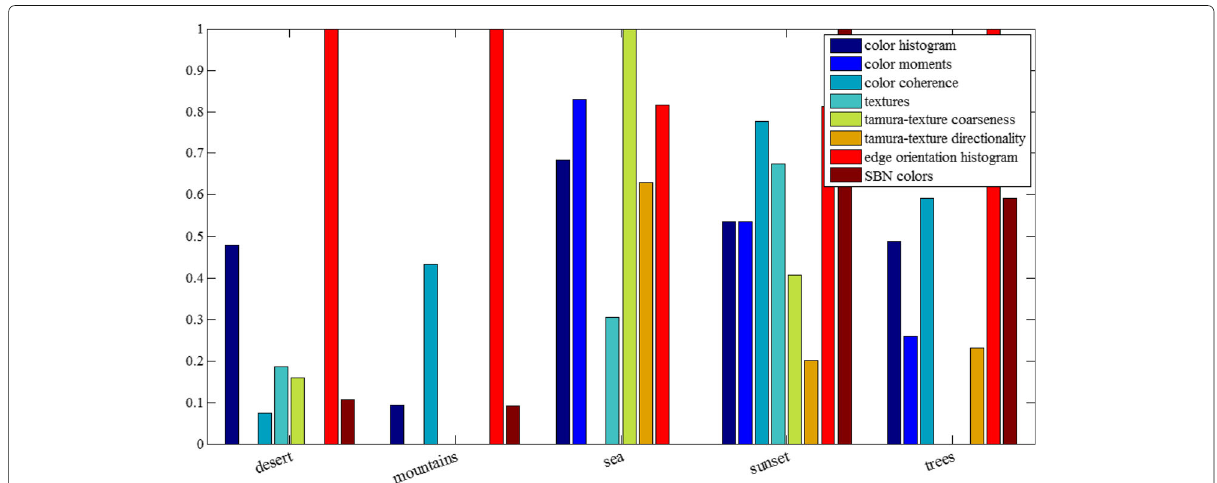
Fig. 6 Relative contribution ratios of features for each class of MIML